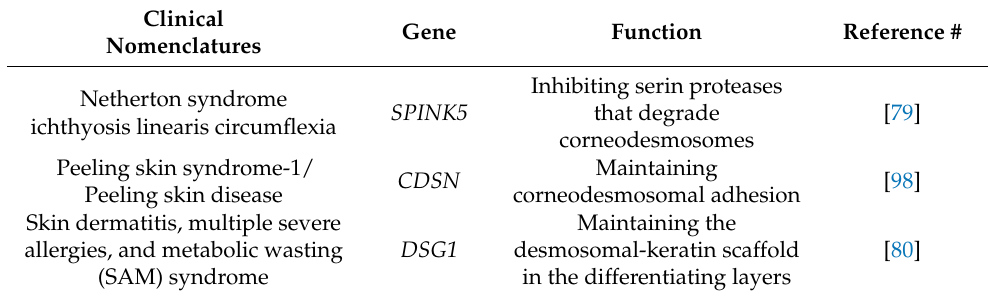
Table 2. Desmosomal Defects Accompanying Allergic